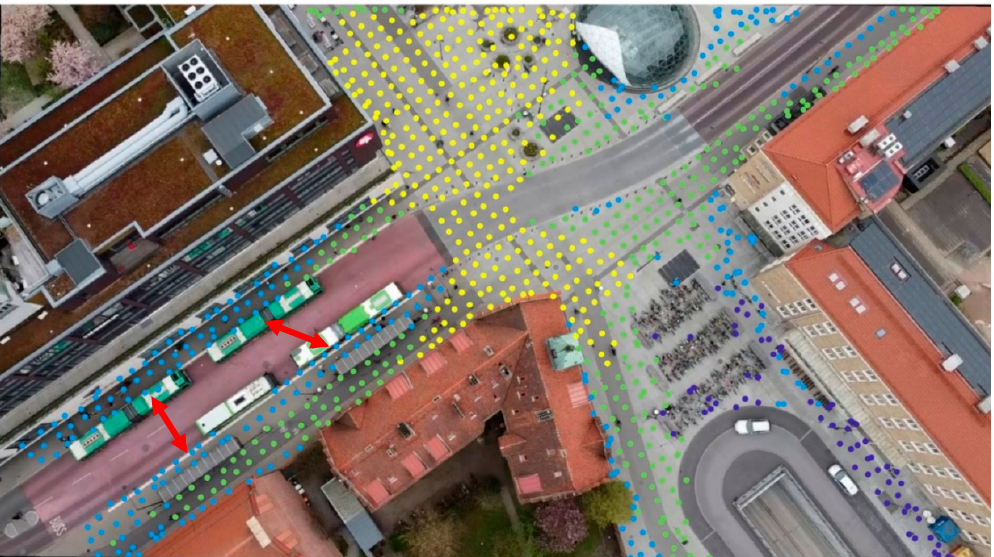
Figure 9. One of the camera views at Triangeln showing integration level levels (yellow, green, light blue and dark blue). The red arrows point towards four bus stops which have been included in integration level 3 (light blue).